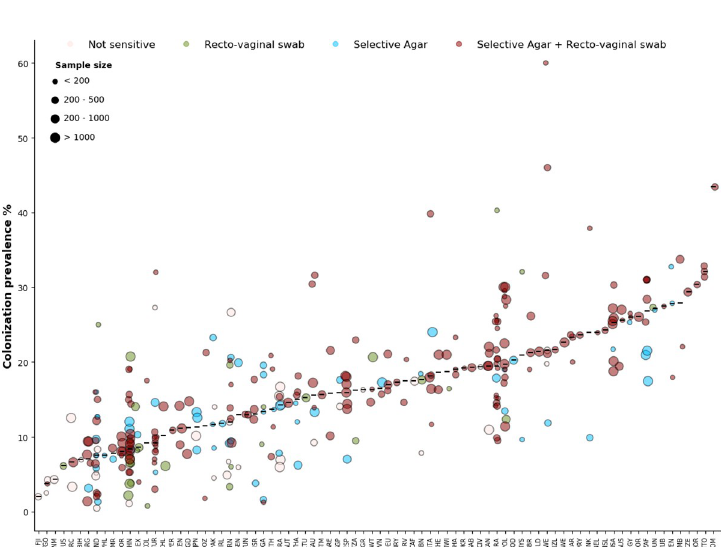
Fig 2. Data used in the hierarchical model of maternal GBS colonization. Study-specific percentages of mothers colonized by GBS (circles) are presented (y-axis) by country (ISO3 codes are shown in the x-axis; arranged in order of increasing median prevalence). Colors represent different combinations of microbiological methods and anatomical sampling sites. Horizontal lines represent median maternal GBS colonization prevalence of the studies in each country. The diameter of the circles is determined by the sample size in each study (see upper left corner of the figure).